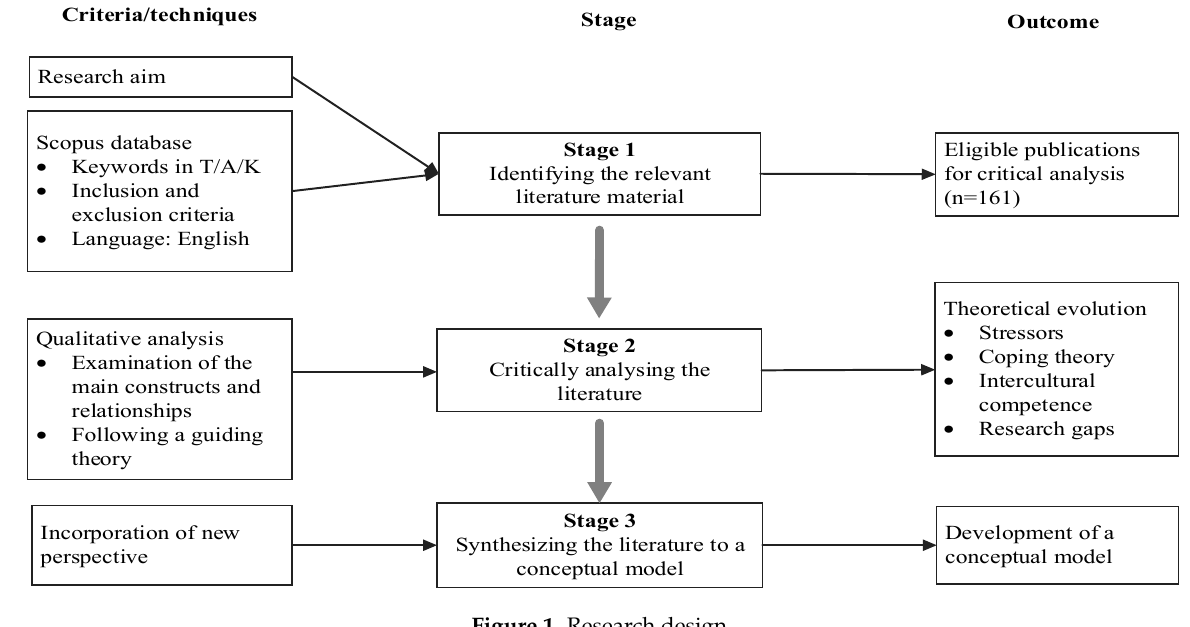
Figure 1. Research design.